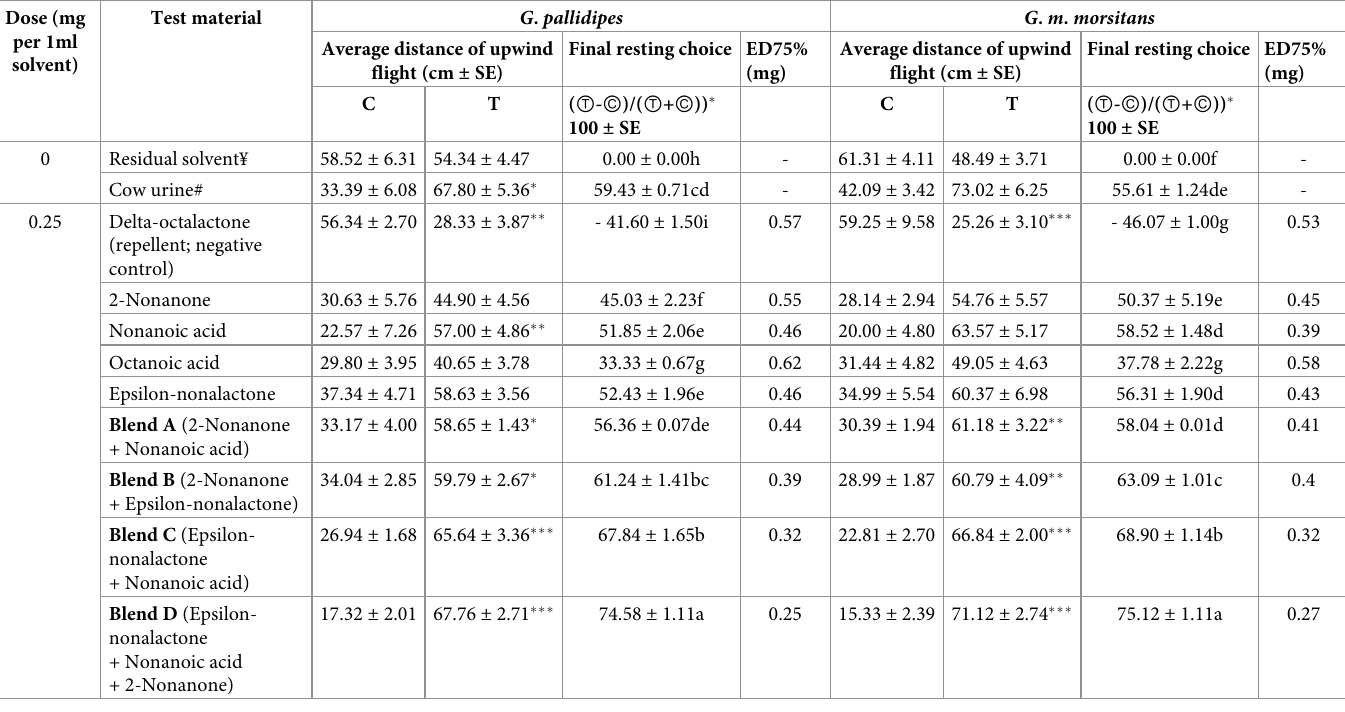
Table 1. Laboratory behavioral responses of G . pallidipes and G . m . morsitans in a wind tunnel to selected compounds/blends related to waterbuck.